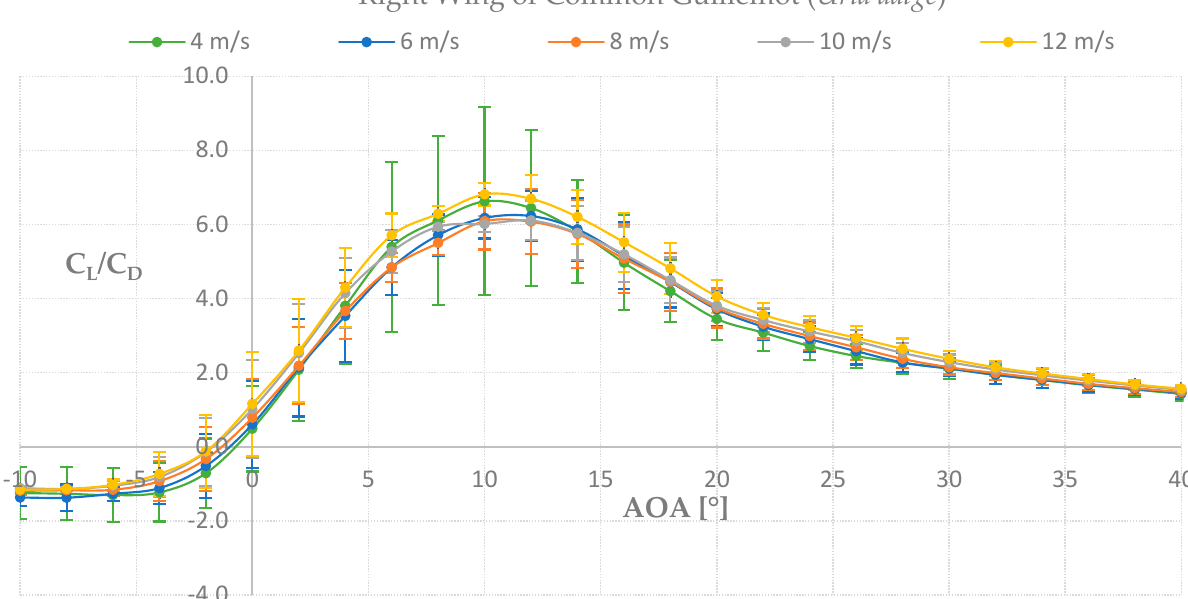
Figure 12. Force measurements of lift − to − drag coefficient against angle of attack for the right wing.